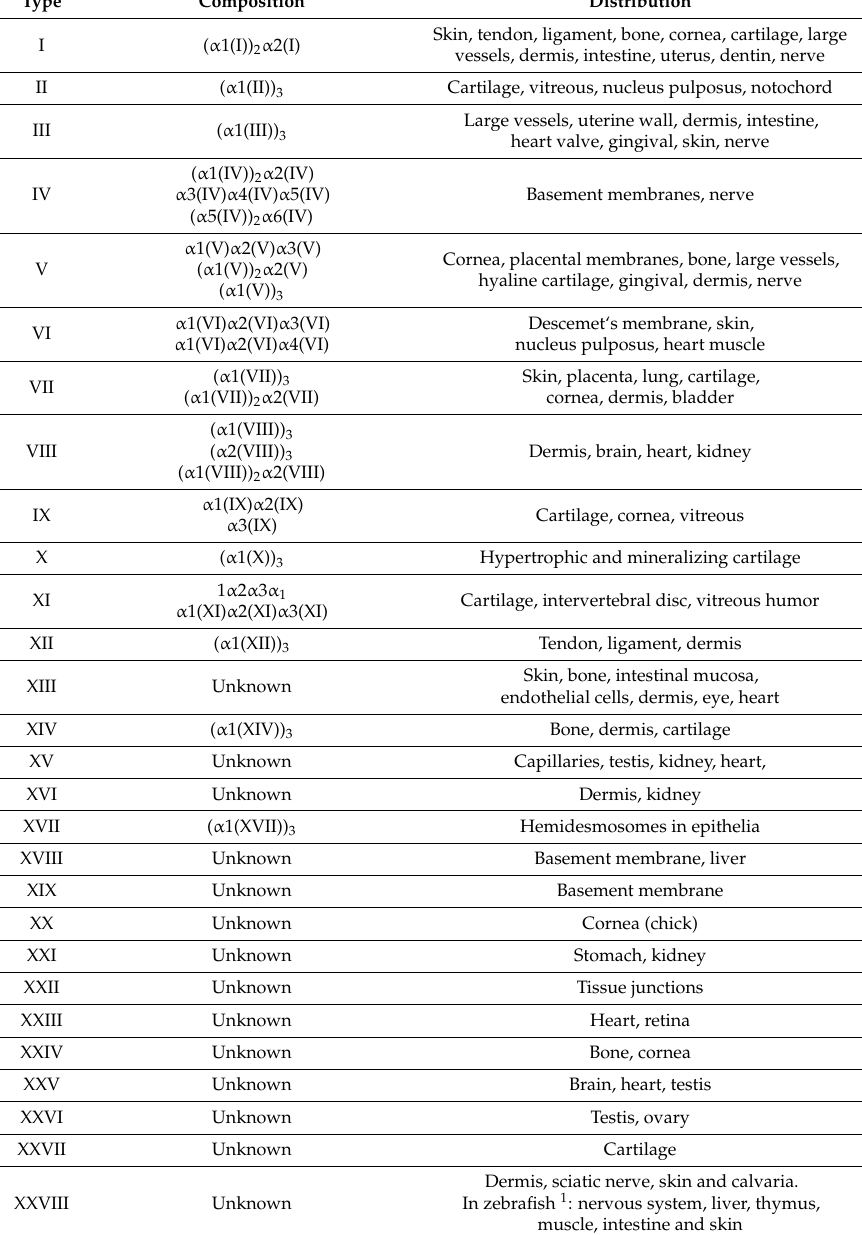
Table 1. Collagen types, their chain composition and distribution (modified from [9,23,24]). Type Composition Distribution